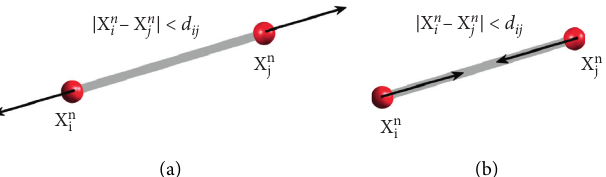
n i and X j : (a) repulsive force when